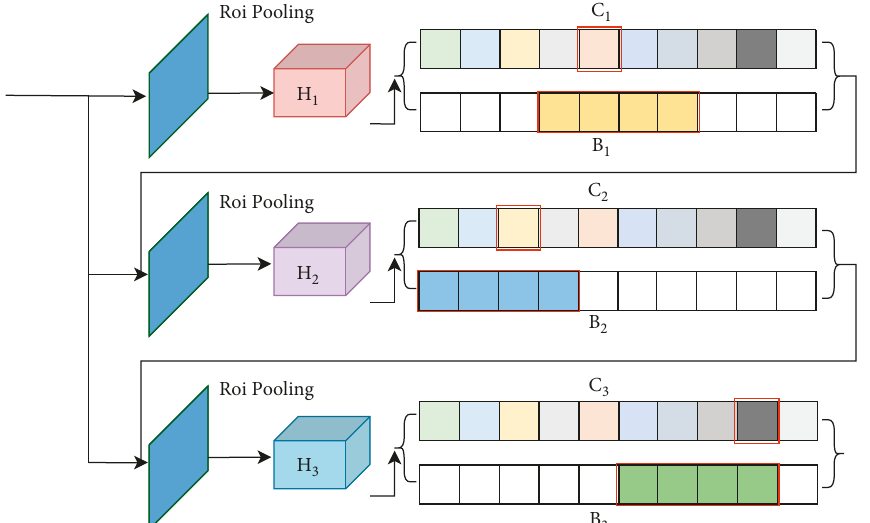
Figure 5: Structure of the cascade detector. Feature maps are fed into the cascade detector, and classification and bounding box regression are refined to optimize prediction, in which C n and B n represent classification and bounding box regression in n stage,